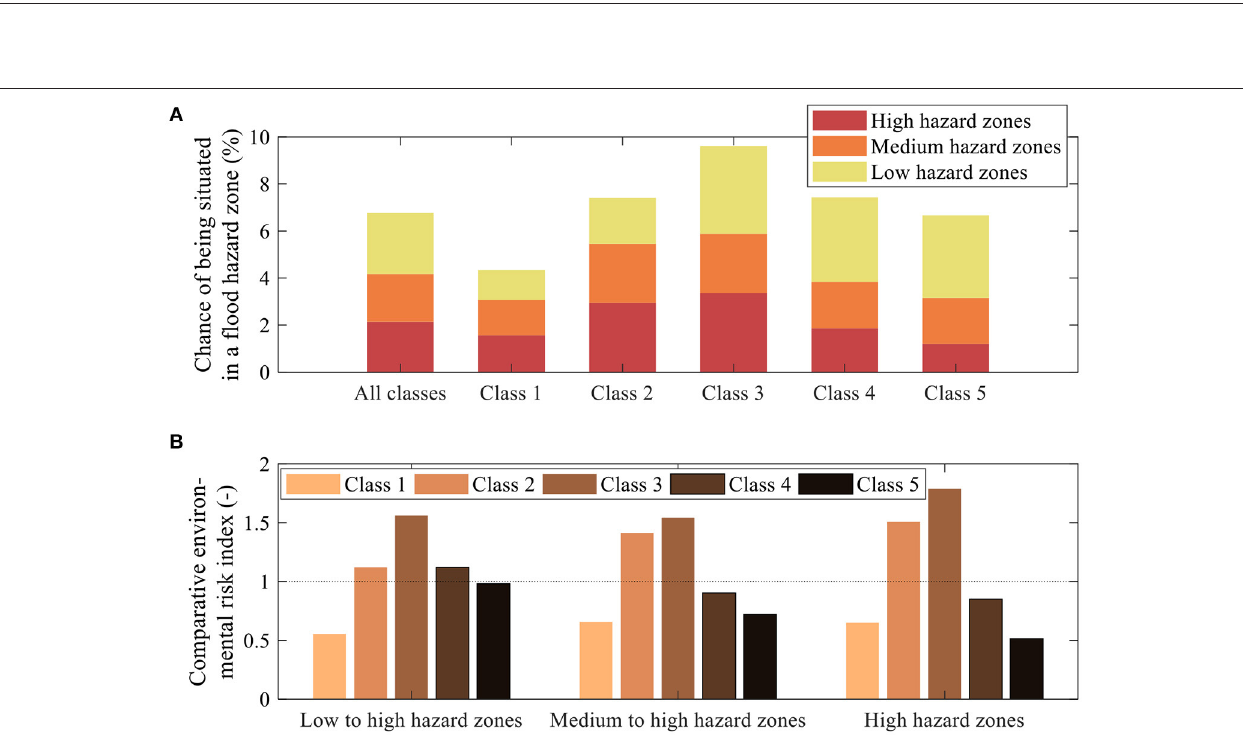
Frontiers in Water |